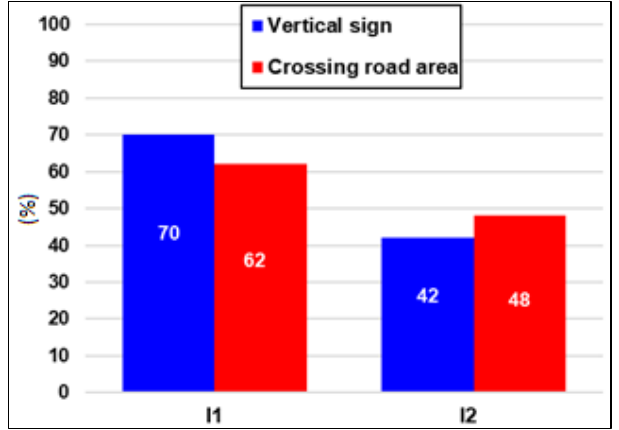
Figure 6. Percentage of drivers that looked at crossing road area (pavement) and at vertical signs (portal overhead bicycle/pedestrian crossing sign for “I1” and “Yield here to pedestrians and cyclists” vertical sign for “I2”).